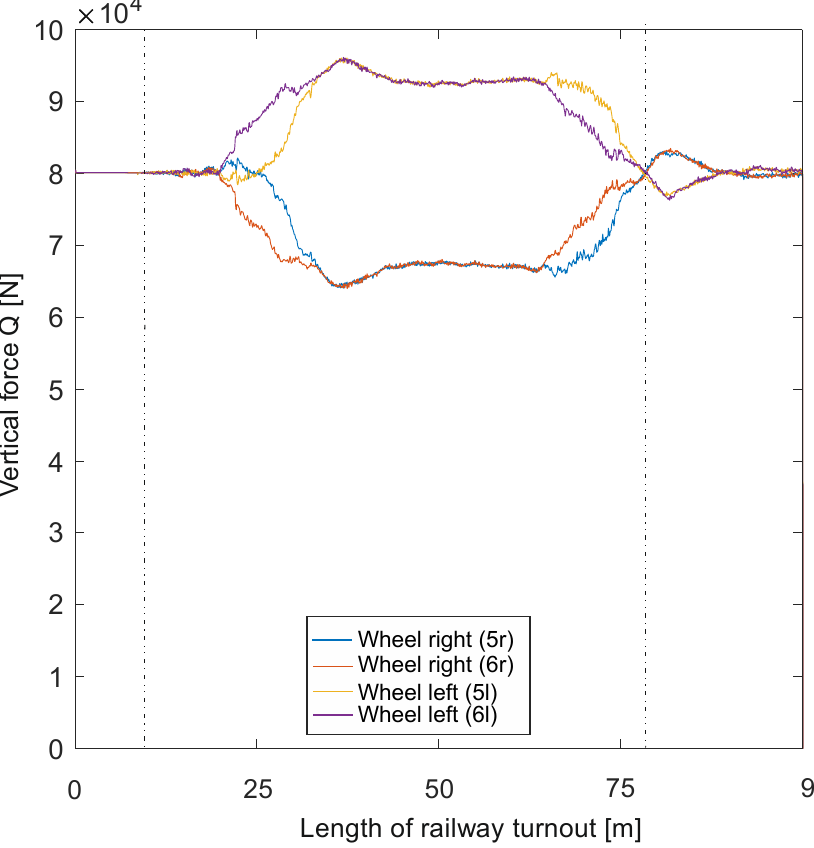
Figure 6. Vertical force on wheels at 100 km/h on straight track through a turnout.